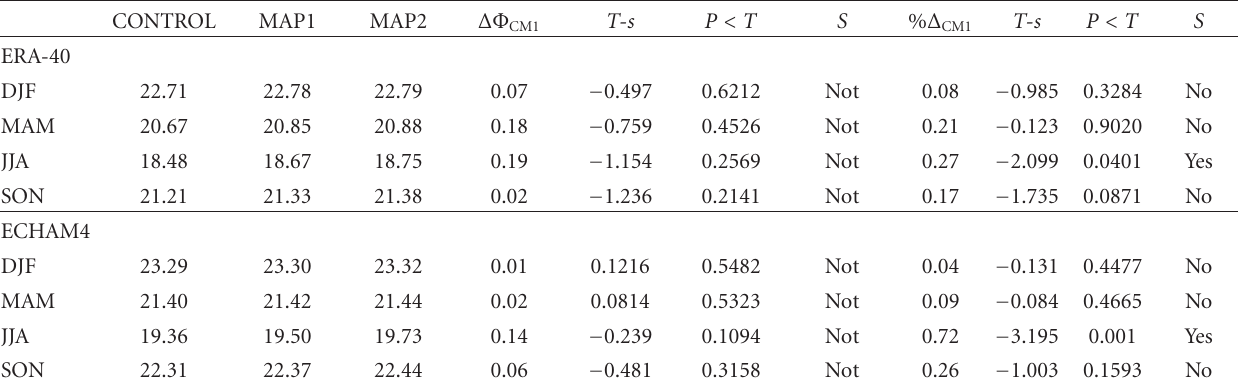
Table 2: Consequences of deforestation/land-use change on the seasonal mean temperature ( ◦ C) averaged over the model domain. ΔΦ CM1 corresponds to the di ff erence CONTROL map minus MAP1 map. Similarly, ΔΦ CM2 is the di ff erence CONTROL map minus MAP2 map. T-s is the Student’s t -test, and P > T is the probability of occurrence. S denotes the significance, if “yes”, the di ff erences are significant, if “no”, then the di ff erences are not significant. Upper half corresponds to ERA40 runs and the lower half to